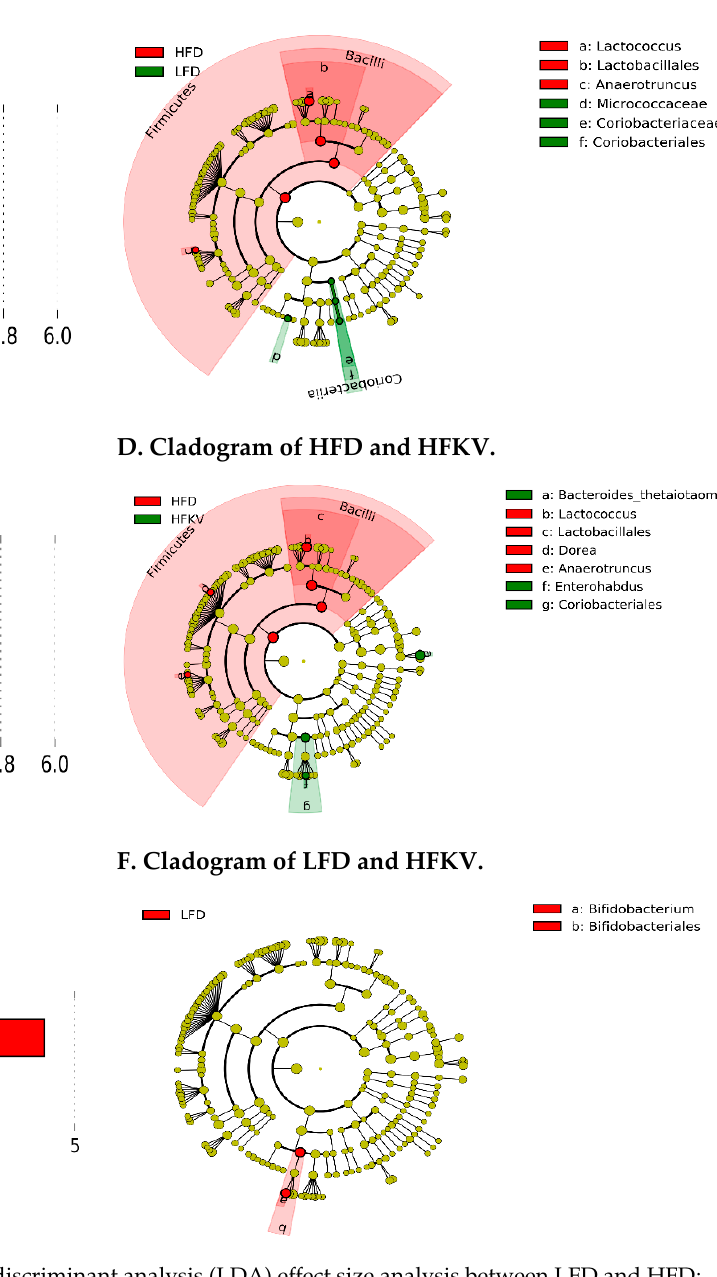
Figure 3. Linear discriminant analysis. ( A ) Linear discriminant analysis (LDA) effect size analysis between LFD and HFD; ( B ) Cladogram of differentially abundant taxonomic clades; LDA score >4.0 among LFD and HFD; ( C ) Linear discriminant analysis (LDA) effect size analysis between HFD and HFKV; ( D ) Cladogram showing differentially abundant taxonomic clades with an LDA score >4.0 among HFD and HFKV; ( E ) Linear discriminant analysis (LDA) effect size analysis between LFD and HFKV; ( F ) Cladogram showing differentially abundant taxonomic clades; LDA score >4.0 among LFD and